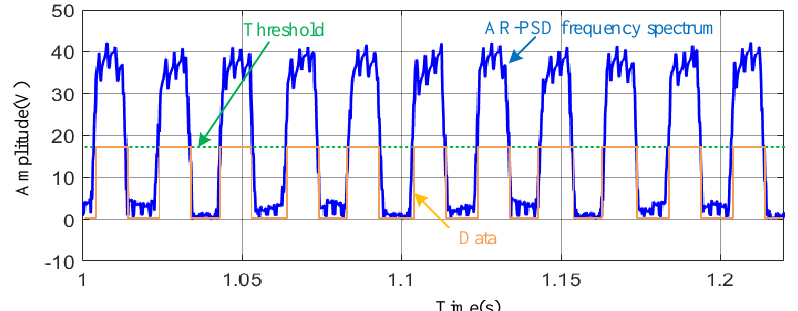
Figure 24. Frequency spectrum and demodulated data as the transmission resistance is 4 Ohm.